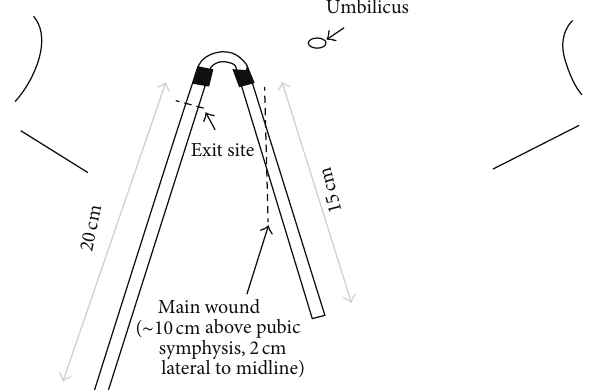
Figure 1: Location of main wound and exit